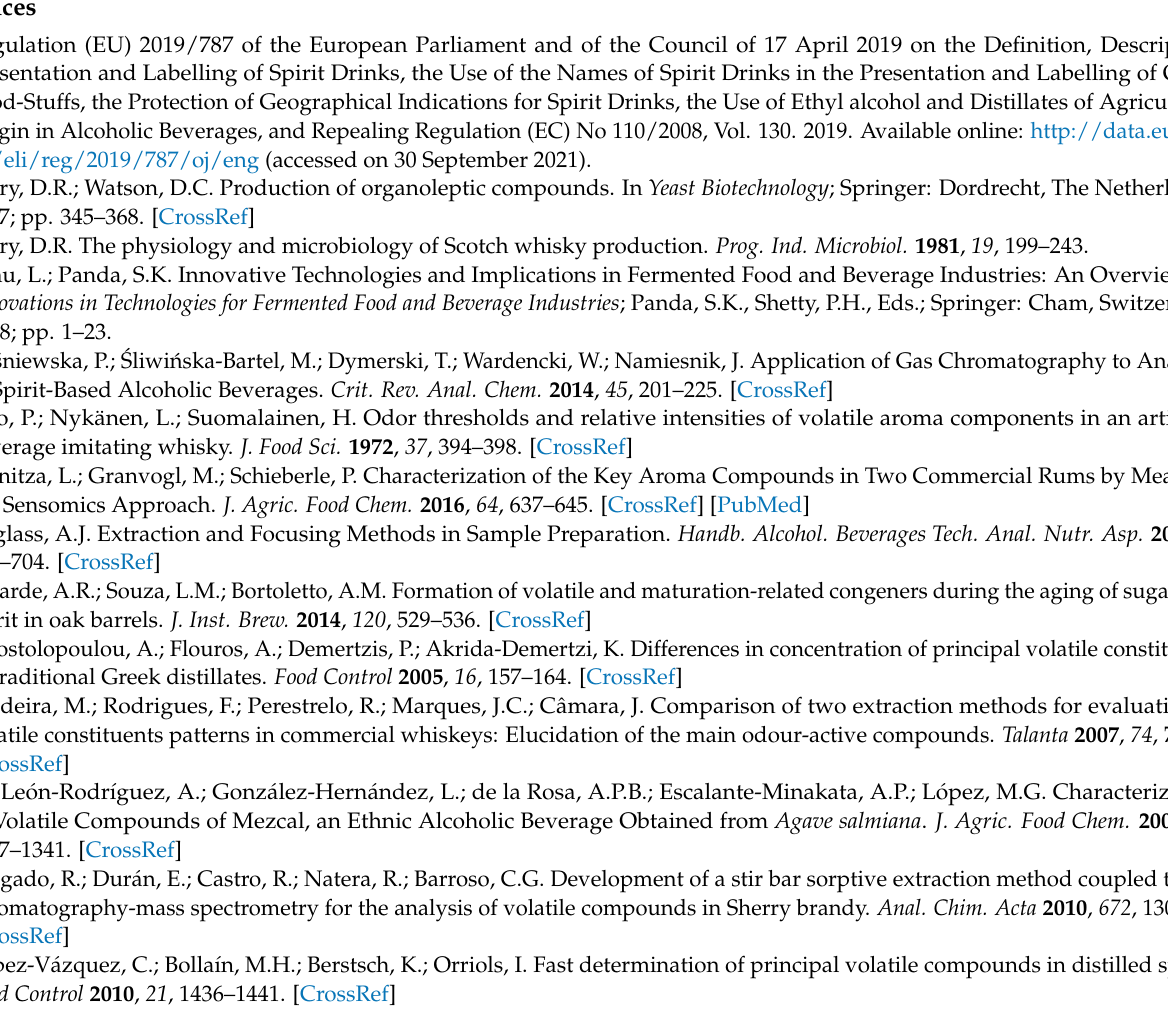
Table S3: Selected SPME conditions for the extraction of distilled spirits; Table S4: Selected SBSE conditions for the extraction of distilled spirits; Table S5: Most abundant m/z of unknown com- pounds with no identified chemical class in gin, whiskey and rum; Figure S1: TIC chromatogram of 44 ◦ N gin; Figure S2: TIC chromatogram of Glenfiddich whiskey; Figure S3: TIC chromatogram of Diplom á tico